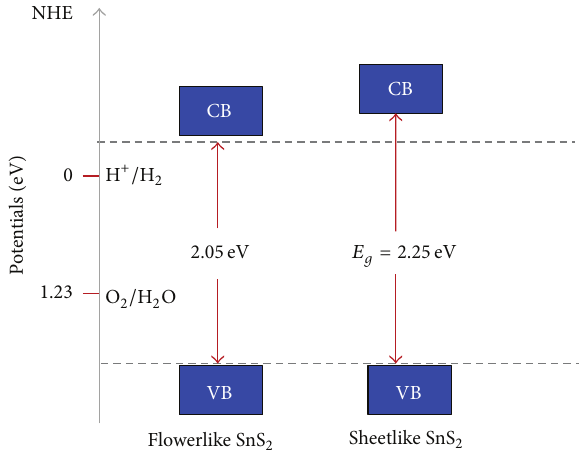
Figure 5: Schematic illustration of the electronic band structures of sheetlike and flowerlike SnS 2 samples.